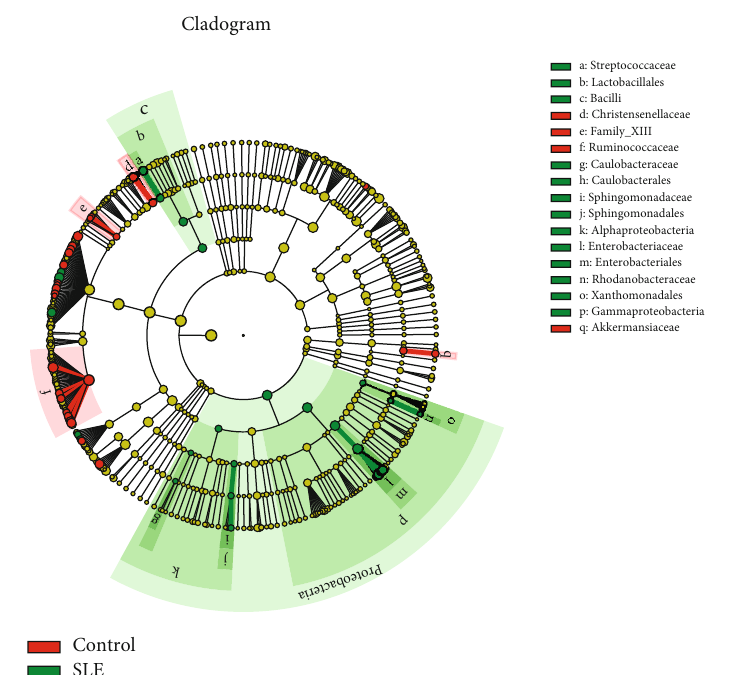
Figure 3: Di ff erential analysis using LEfSe software. Red nodes represent the microbial group that plays an important role in the HC group, green nodes represent the microbial group that plays an important role in the SLE group, and yellow nodes represent the microbial group that does not play an important role in both